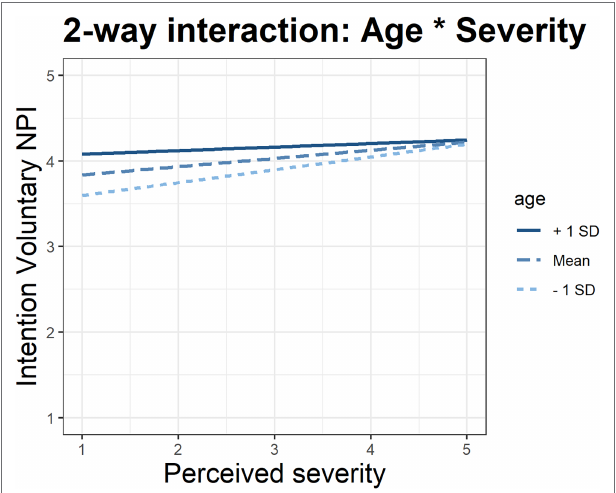
FIGURE 3 | Two-fold interaction effect between age and